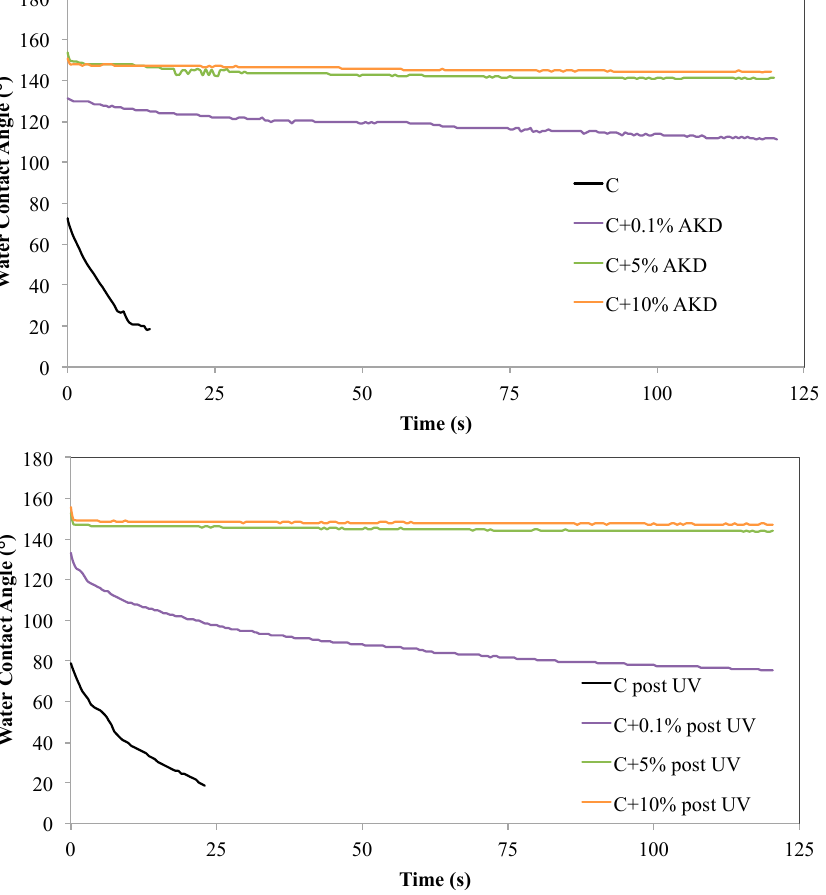
Figure 1. WCA values over time on cedar wood samples, before ( top ) and after the UV treatment ( bottom ).